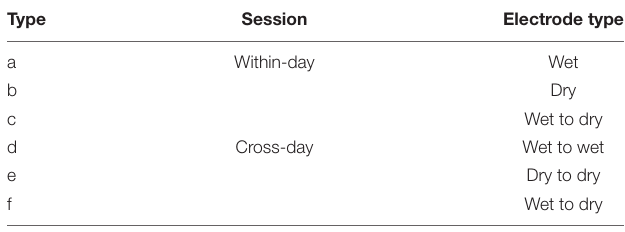
TABLE 1 | The type of transfer direction.